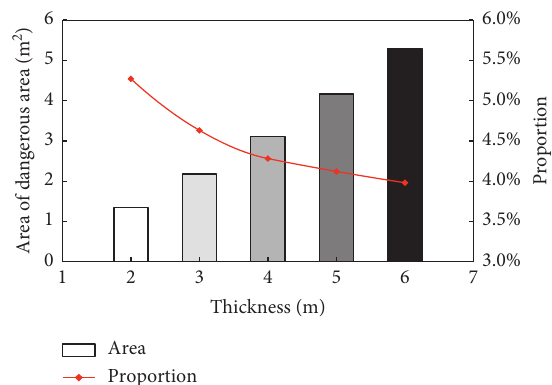
Figure 10: Size of crack-affected area vs. proportion of crack-af- fected area.